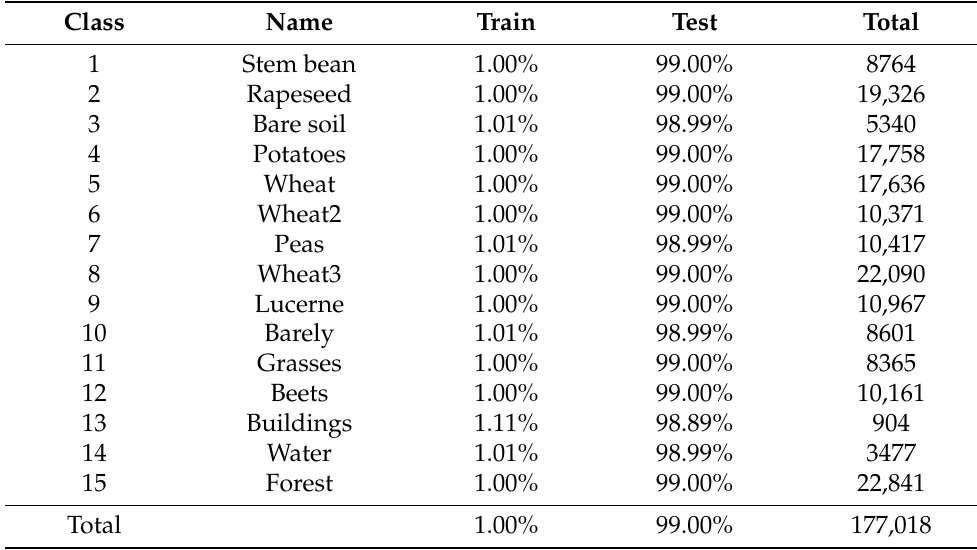
Table 3. The image information of Flevoland